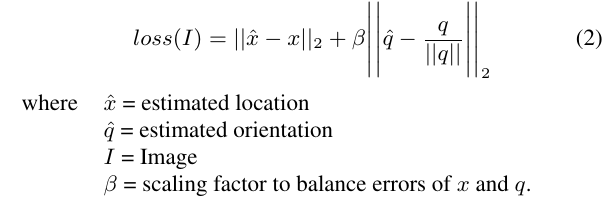
Figure 2. The 3D model derived from a BIM. The trajectory used for generating synthetic dataset is shown in green color. For better visualisation of the indoor space, the roof was